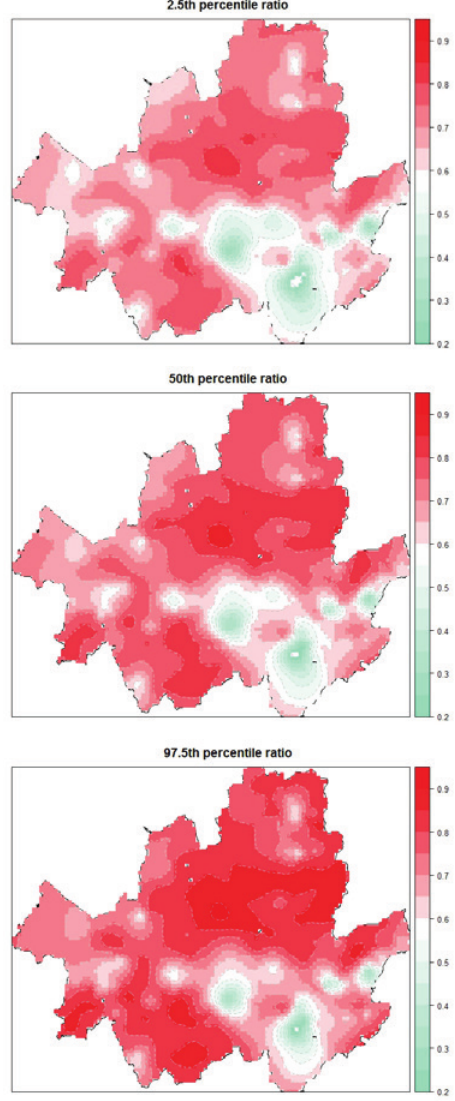
Figure 11. Fitted ratio distributions as of October,